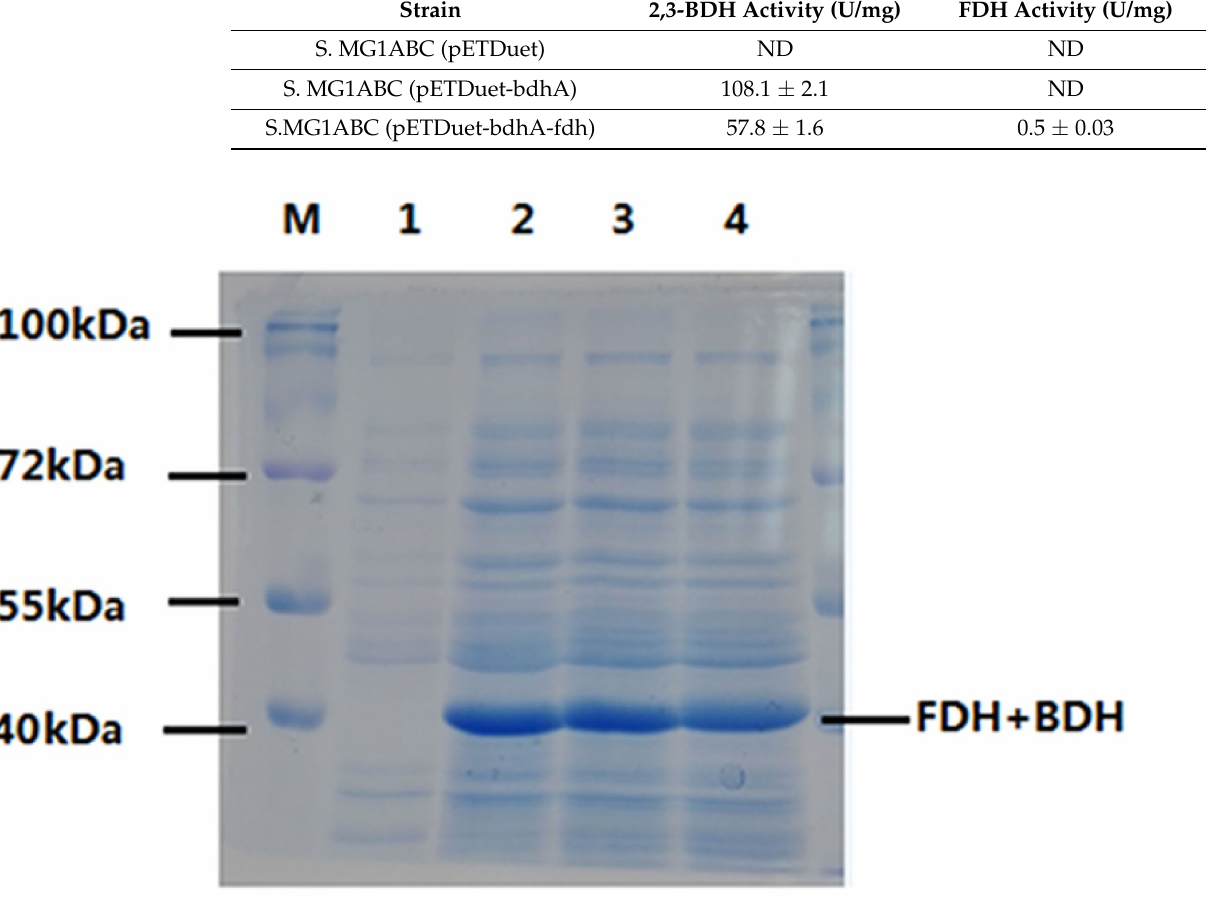
Figure 4. Identification of the expression of 2,3-BDH and FDH in Serratia marcescens by SDS-PAGE. M, maker; lane 1, Serratia marcescens MG1ABC (pSWNB+pETDuet); lane 2, Serratia marcescens MG1ABC (pSWNB+pETDuet-bdhA); lane 3, Serratia marcescens MG1ABC (pSWNB+pETDuet-fdh); lane 4, Serratia marcescens MG1ABC